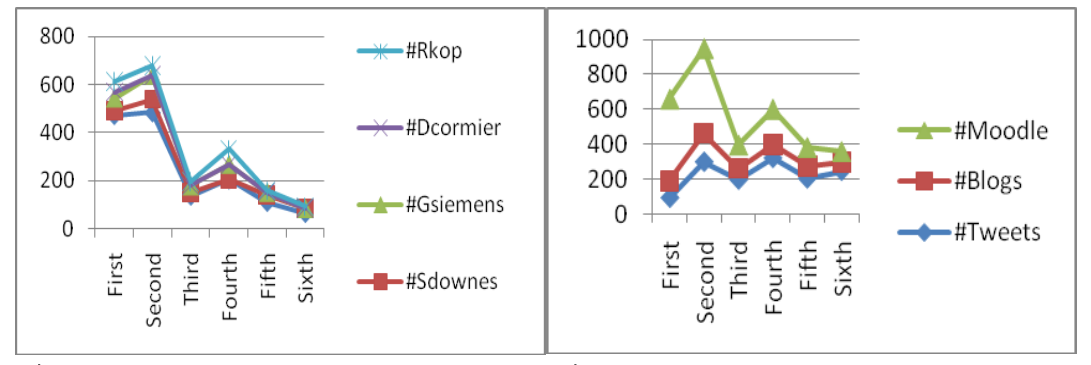
Chart 4 . Posting by